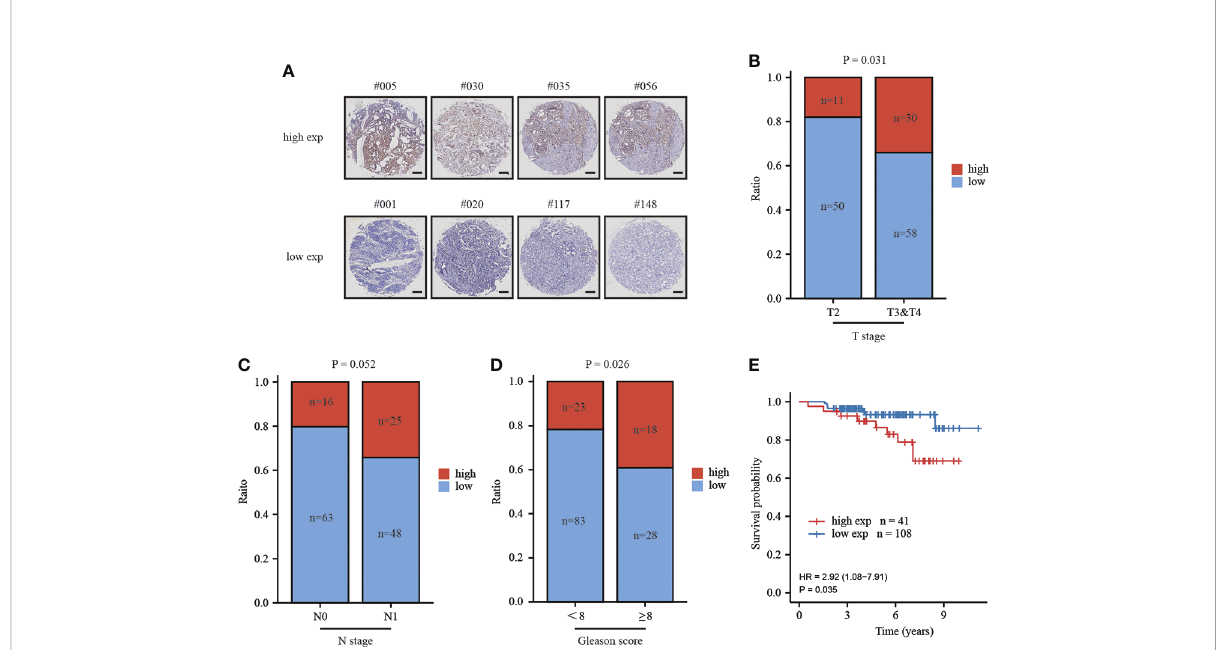
FIGURE 3 high expression of MAFG-AS1 indicated a poor prognosis. (A) Representative ISH results of prostate cancer patients in different groups (Scale bar: 200 m m) (B) MAFG-AS1 expression in prostate cancer in T3&T4 or T2 stage by in situ hybridization (ISH). (C) MAFG-AS1 expression in prostate cancer in N1 or N0 stage by in situ hybridization (ISH). (D) MAFG-AS1 expression in prostate cancer in Gleason score<8 or ≥ 8. (E) High expression of MAFG-AS1 indicated a poor overall survival (OS) by Kaplan-Meier analysis.